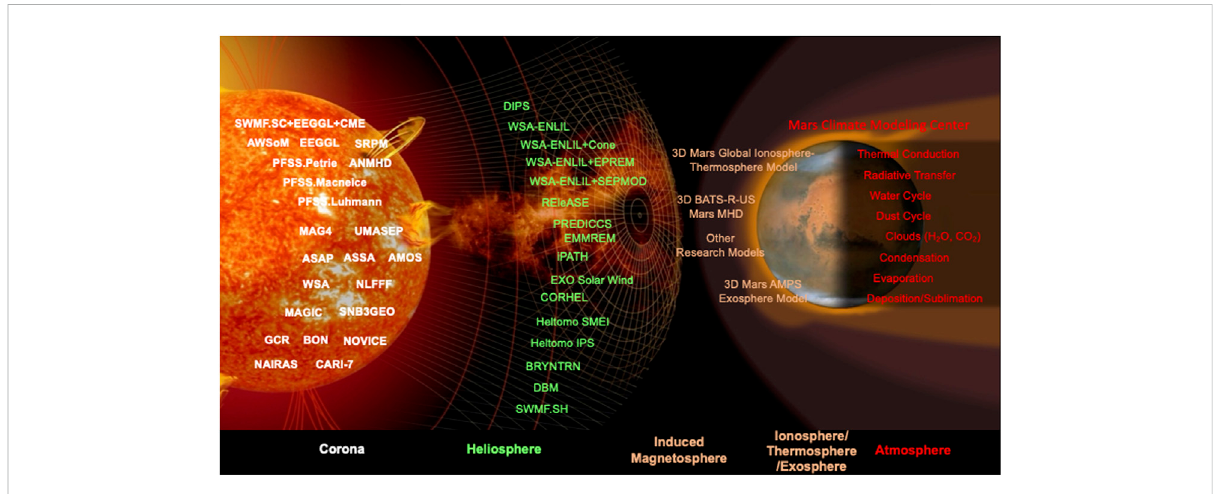
FIGURE 3 The comprehensive MSWA system will be using a variety of existing models, currently in operational use in the CCMC (e.g., solar corona and heliosphere), a series of new models for the induced magnetosphere, ionosphere/thermosphere/exosphere, and those in the